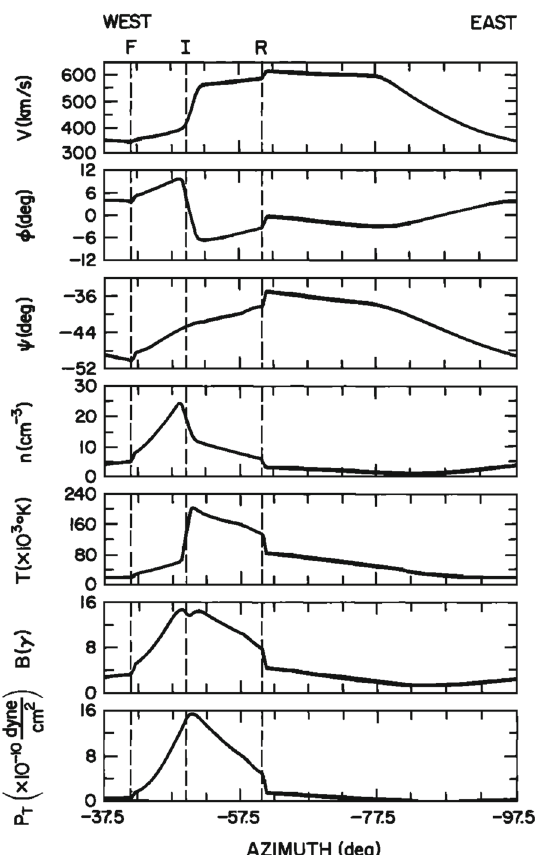
Fig. 13 Equatorial solution for an initially steep-sided circular stream at I AU. F and R mark the forward and reverse wave fronts, which demarcate the dynamic compression ridge. The two shocks propagate in opposite directions, but both are convected outward in the bulk flow. The interface, I, is a shear layer separating fast and slow flow regimes that initially had very different fluid properties. Image reproduced